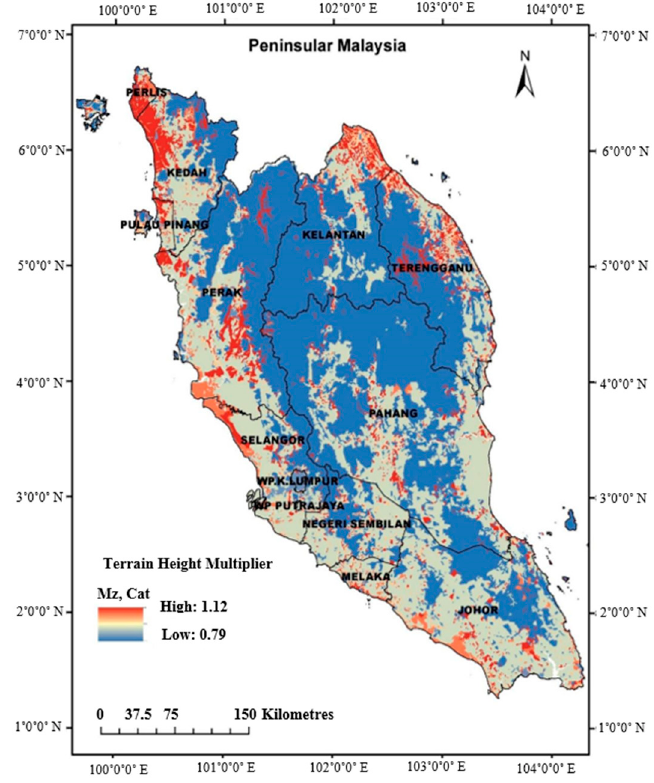
Figure 7. The Terrain Height Multiplier ( M z,cat ) map for Peninsular Malaysia.